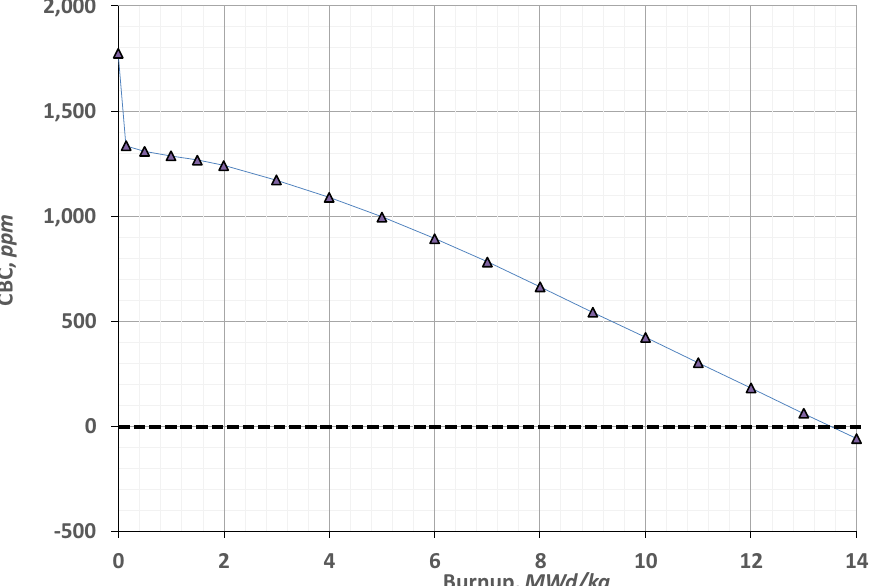
Fig. 9. Comparison of the critical boron concentration (ppm) as a function of burnup in